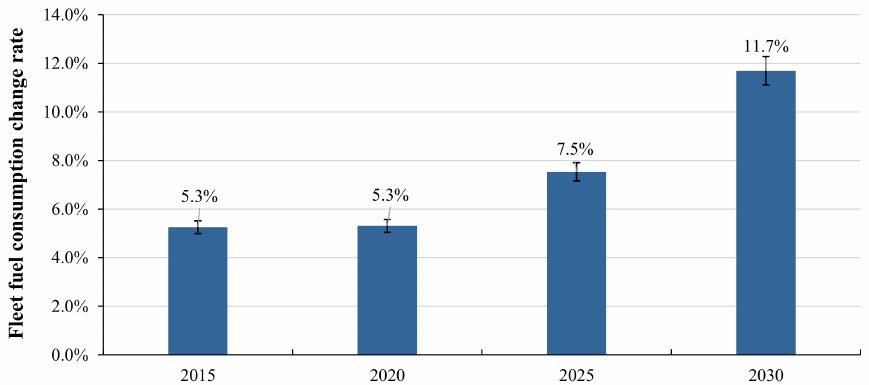
Figure 11. Change rate of China’s fleet fuel consumption under different test procedures. Notes. (1) The error bars represent the value range under 5% margin of